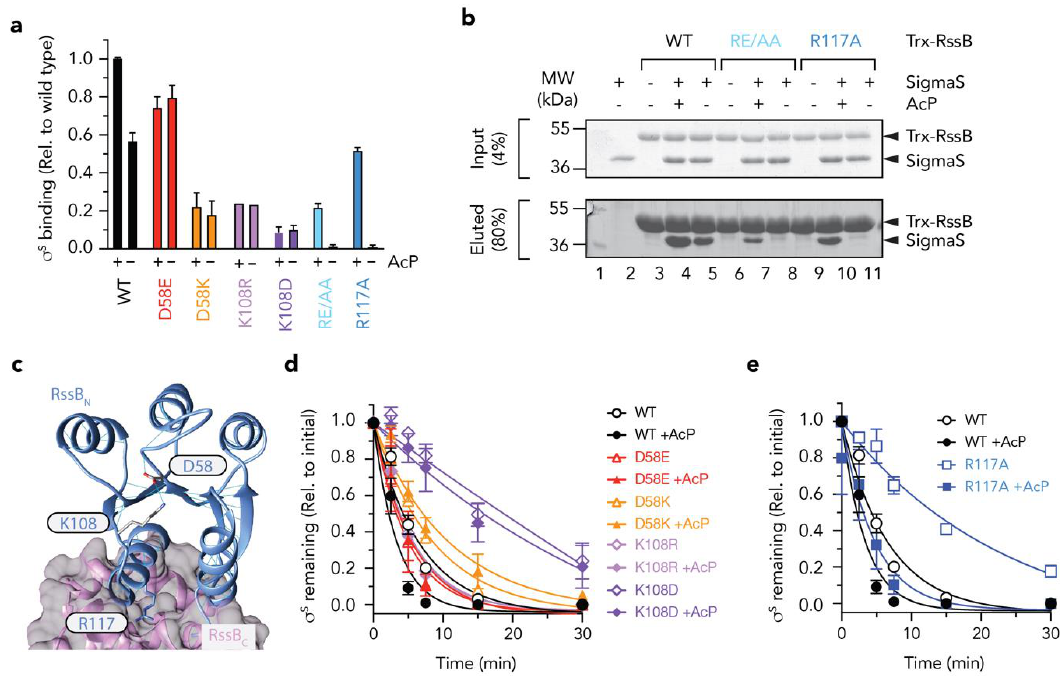
Figure 6. The N- terminal domain of RssB regulates docking to σ s . ( a ) Quantitation of in vitro σ s “pull - down” experiments showing the binding of σ s to various RssB mutant proteins (D58E, red bars; D58K, orange bars; K108R, mauve bars; K108D, purple bars; RE/AA, light blue bars; R117A, dark blue bars) relative to wild type Trx-RssB (black bars) in the presence or absence of AcP. ( b ) In vitro σ s “pull - down” experiment illustrating the interaction of σ s (lane 2) with wild type Trx-RssB (lanes 3 – 5), Trx- RssB RE/AA (lanes 6 – 8) and Trx-RssB R117A (lanes 9 – 11), in the presence (lanes 4, 7, 10) or absence (lanes 5, 8, and 11) of AcP. MW markers (lane 1). Proteins were separated by 15% SDS-PAGE and visualized by staining with Coomassie Brilliant Blue. The input (4%) is shown in the upper panel and the eluted proteins (80%) are shown in the lower panel. ( c ) Structure of RssB (in IraD bound conformation; PDB: 6OD1) illustrating location of D58, K108 and R117A. ( d , e ) Quantitation of ClpXP-mediated degradation of σ s by wild type and mutant RssB in the presence or absence of AcP (as described in (b). Error bars represent S.E.M. of at least three independent experiments (n > 3), except in the case of K108R, in which only a single experiment was performed (n = 1) and hence no error bars are shown. To validate these findings, we performed a series of experiments in which the bait was reversed.